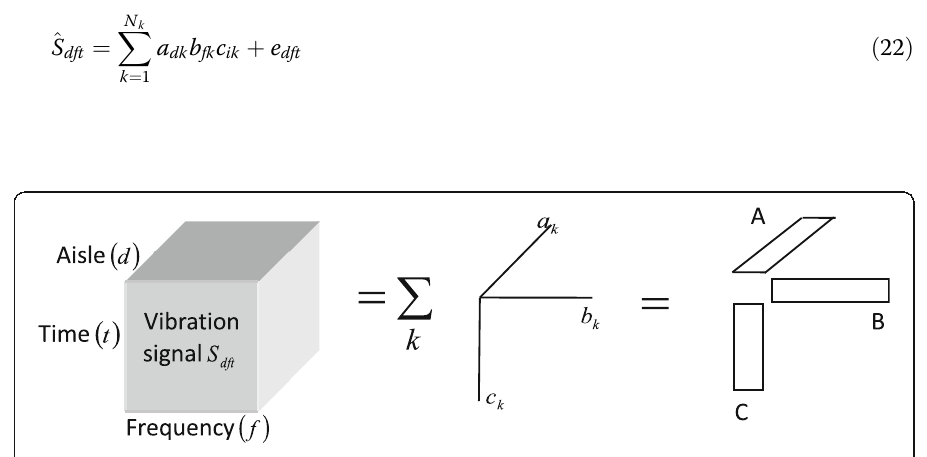
Fig. 3 The model of multi-scale parallel factor decomposition for fault